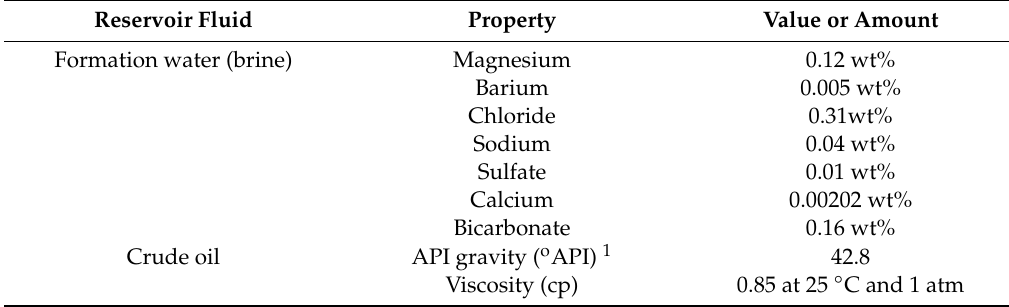
Table 3. Properties of the reservoir